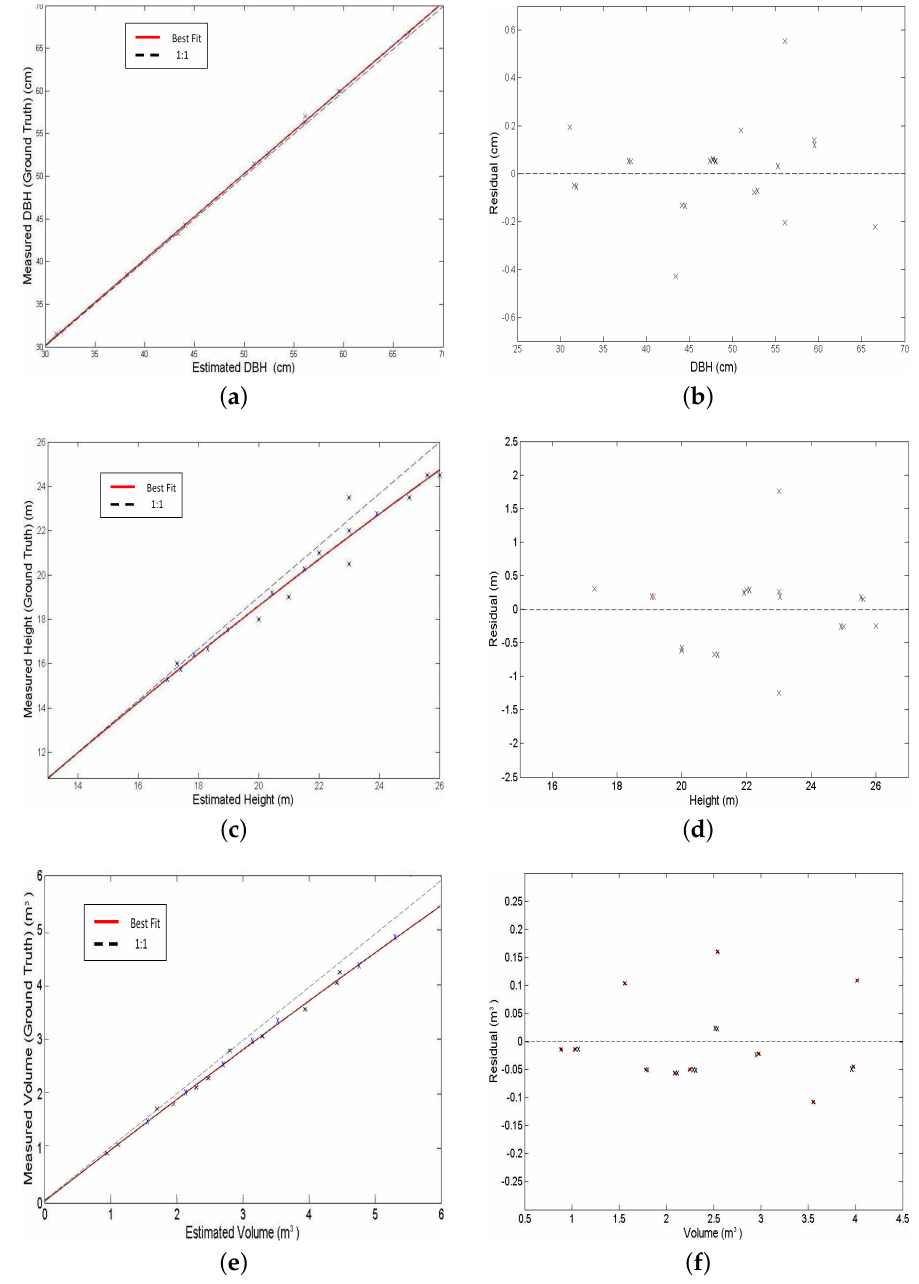
Figure 14. ( a , c , e ) show the regression plots while ( b , d , f ) show the residuals for the estimated DBH , height H and volume V ,